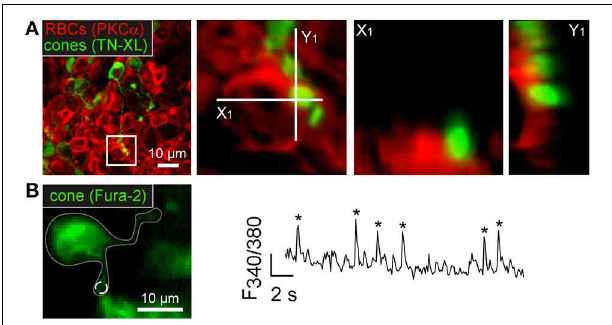
FIGURE 3 | Degenerating cones sprout and contact rod bipolar cells in rd1 mice. (A) Immunolabeled cones (TN-XL, green) and RBCs (PKC α , red) in P35 rd1 retina. Higher magnification view of boxed area showing a RBC soma contacted by a cone neurite. X-images show horizontal and Y-images vertical single-plane sections of higher magnification view. (B) Left: Fura-2-and TN-XL-labeled cone (gray line outlines cone; dashed white circle indicates ROI). Right: Ca 2 + trace ( F 340 / 380 ratio) with transients (indicated by asterisks) recorded in ROI in cone process (white dashed